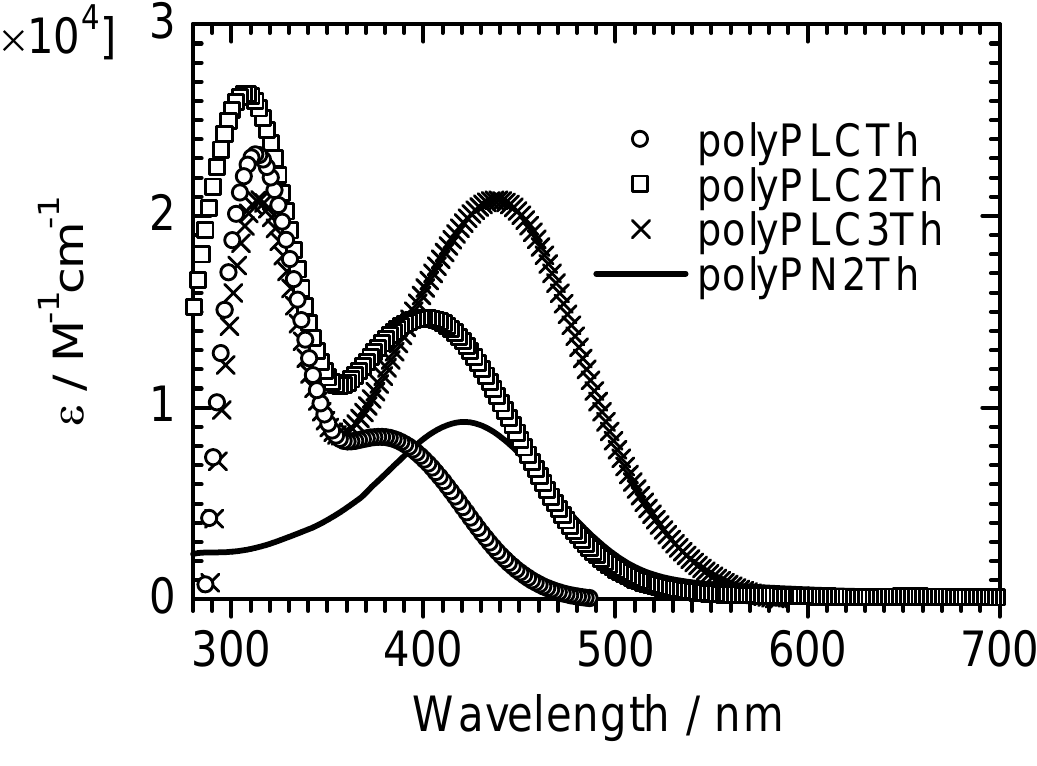
Figure 4. UV-vis optical absorption spectra of the